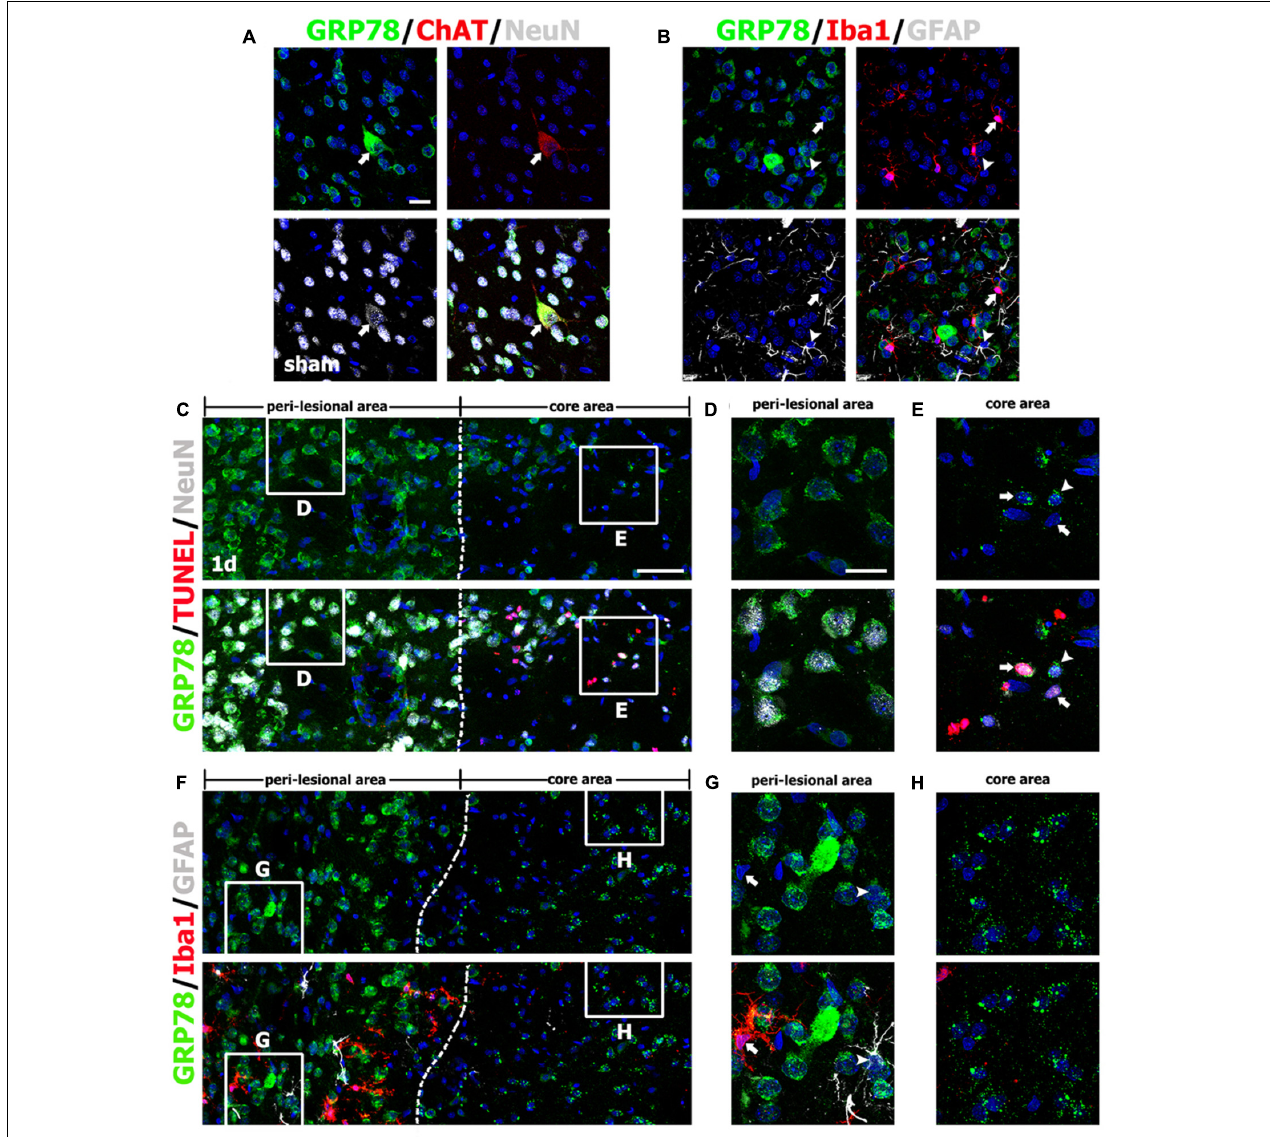
FIGURE 2 | Characterization of glucose-regulated protein (GRP78)-positive cells in the striata of saline-treated control and 3-nitropropionic acid-injected rats on day 1. (A) Triple-labeling of GRP78, neuronal nuclear protein (NeuN), and choline acetyltransferase (ChAT), a specific marker for cholinergic neurons, in control striatum, showing that GRP78 expression is localized in almost all NeuN-positive neurons and also in some cholinergic interneurons (arrows). (B) Triple-labeling of GRP78, ionized calcium-binding adaptor molecule 1 (Iba1), and glial fibrillary acidic protein (GFAP) in the striatum of a control rat, showing that neither microglia (arrows) nor astrocytes (arrowheads) show specific immunoreactivity for GRP78. (C–E) Lower- (C) and higher- (D,E) magnification views of sections triple-labeled for GRP78, NeuN, and terminal deoxynucleotidyl transferase dUTP nick end labeling (TUNEL) 1 day after lesion induction. The boxed areas of the peri-lesional area (left side of the broken line) and the lesion core in C are enlarged in D and E , respectively. Notably, GRP78 expression is very weak to negligible in nearly all TUNEL-positive (arrows in E ) and TUNEL-negative (arrowheads in E ) neurons in the lesion core, while neurons in the peri-lesional area show prominent GRP78 immunoreactivity. (F–H) Lower- (F) and higher- (G,H) magnification views of section triple-labeled for GRP78, Iba1, and GFAP 1 day after lesion induction. The boxed areas of the peri-lesional area (left side of the broken line) and the lesion core in F are enlarged in G and H , respectively. Note that astrocytes (arrowheads in G ) and microglia (arrows in G ) in the peri-lesional area show very weak immunoreactivity for GRP78. Cell nuclei are stained with 4 (cid:48) ,6-diamidino-2-phenylindole. Scale bars represent 50 µ m for C , F ; and 20 µ m for A , B , D , E , G , H .